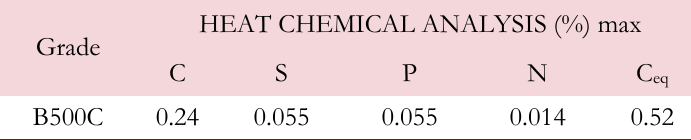
Table 1: Chemical